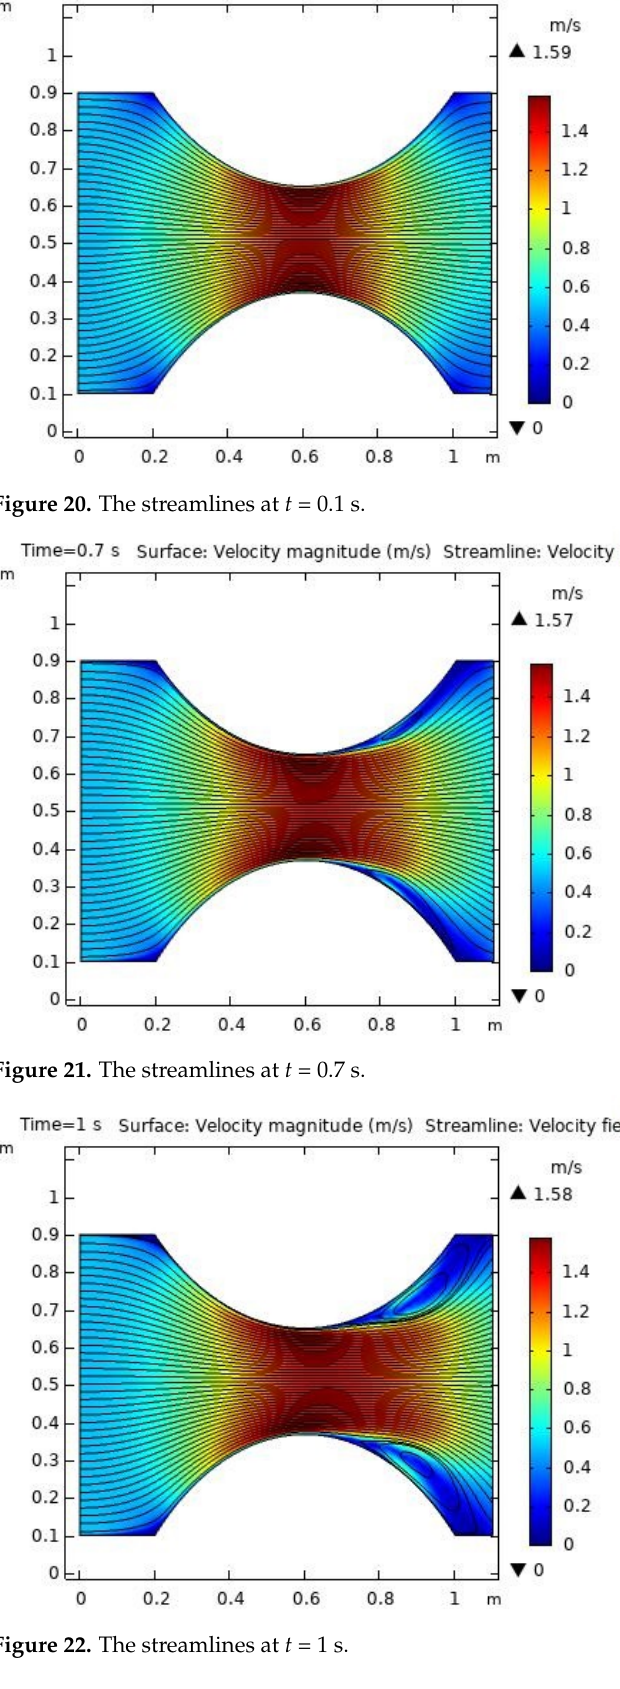
Figure 19. The isothermal contour profile at t = 1 s.